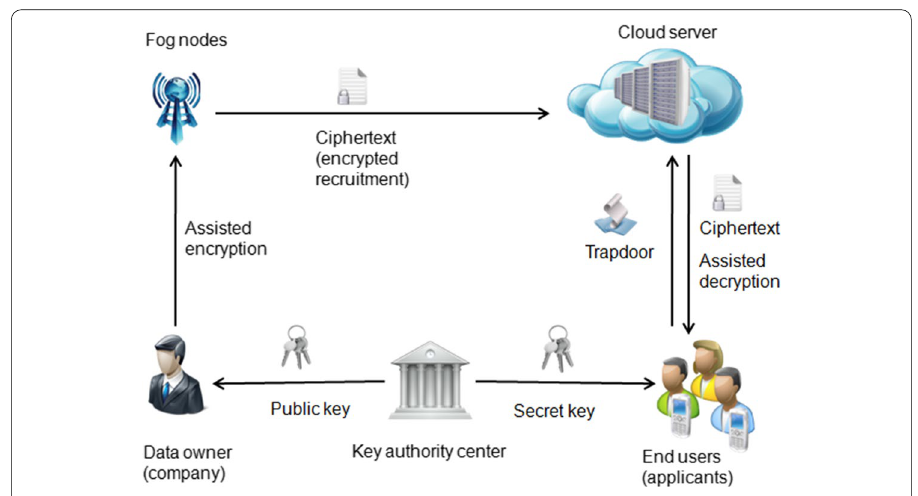
Fig. 6 System description of our